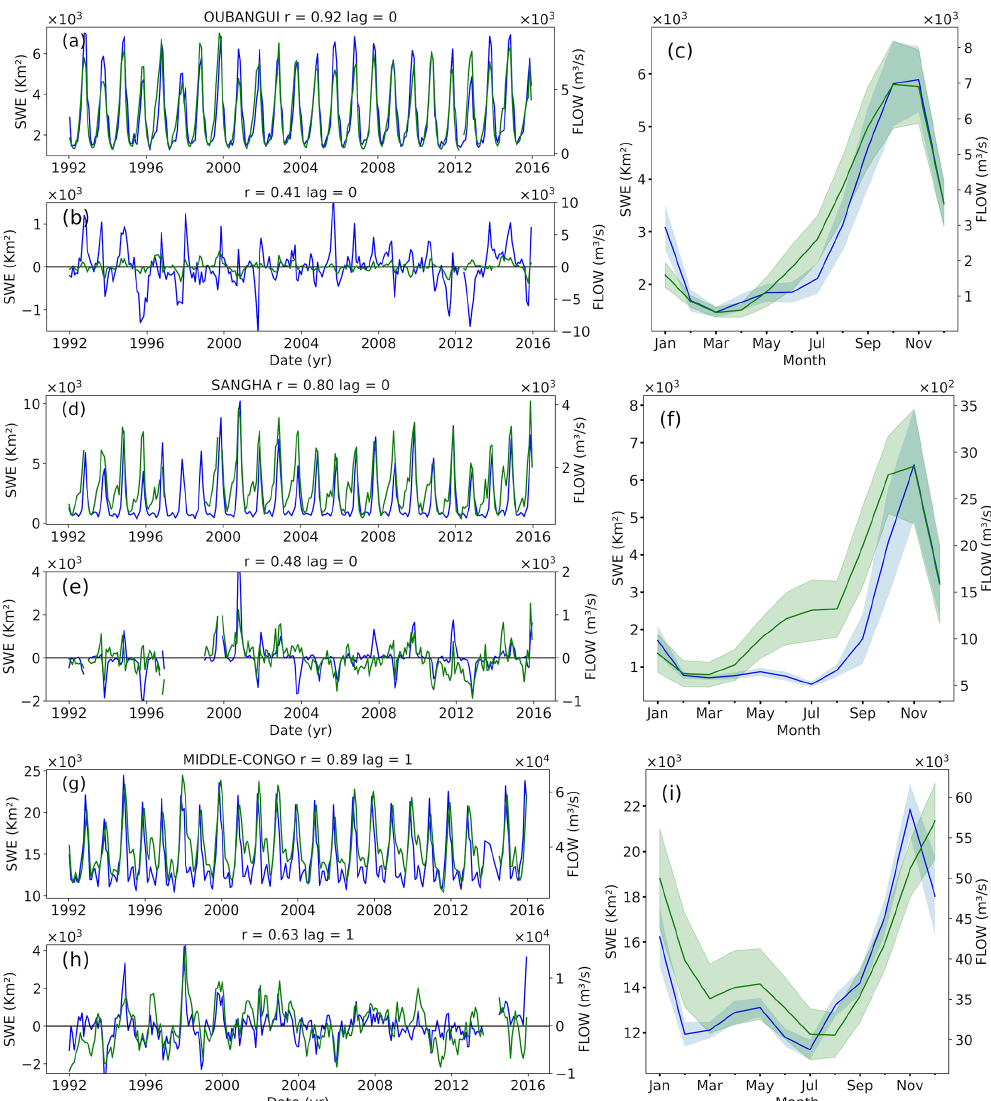
Figure 8. Similar to Fig. 7 but for each of the five subbasins. A comparison of the monthly SWE (absolute and anomaly values) against the in situ water discharge at each subbasin outlet is shown. The blue line is for the SWE, and the green line is for the water discharge. The annual cycle for both variables (1992–2015) is also displayed, with the shaded areas illustrating the standard deviations around SWE and discharge